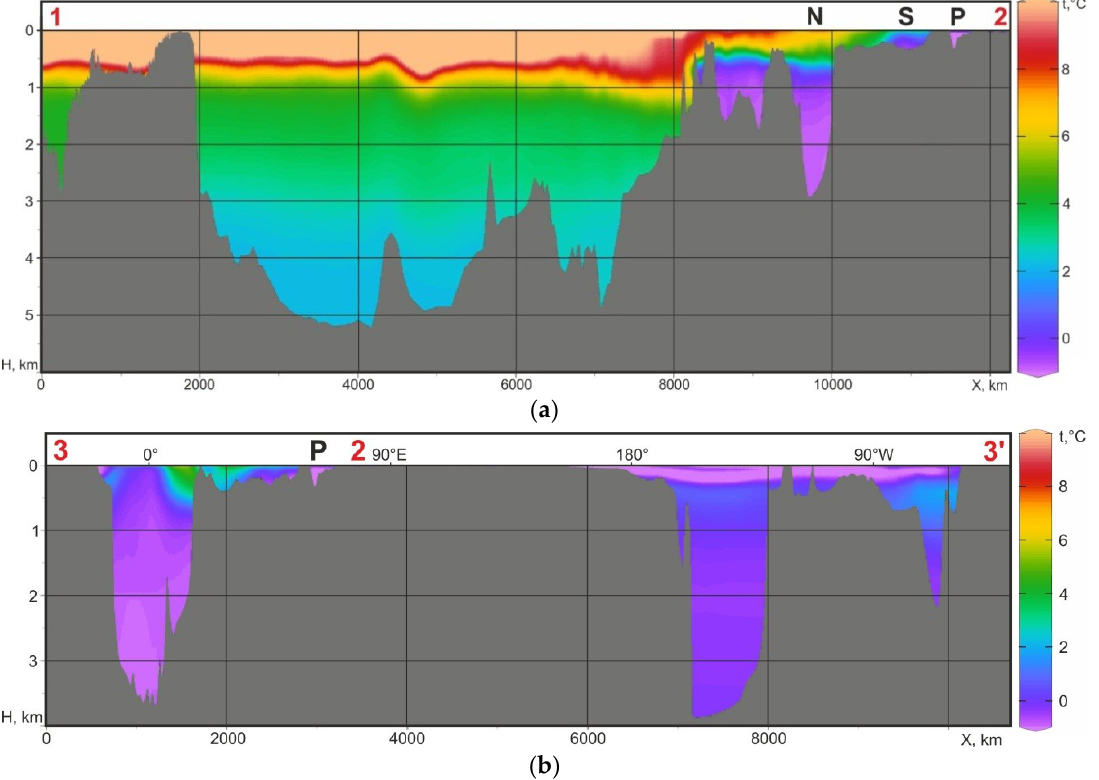
Figure 4. Megaregional water temperature sections for lines 1–2 ( a ) and 3–3’ ( b ), demonstrated in Figure 2.